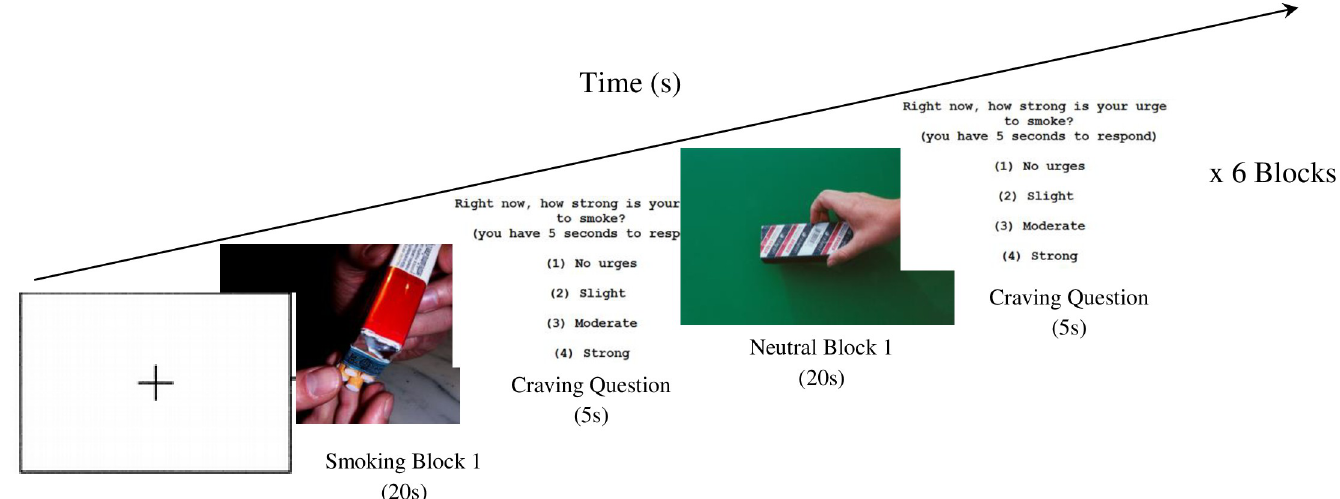
Fig 4. Design for smoking cue reactivity task paradigm (MRI task). During each MRI scan, participants will be presented images for approximately 7 minutes whilst being asked regarding their cigarette craving in between the blocks. The smoking block will consist of pictures related to smoking whilst the neutral block will have neutral images. Each block will last for 35 seconds for a total of 6 blocks. Blood oxygen level signal will be measured during this task. � Photos were taken from the Geneva Smoking Pictures (Khazaal et al. 2012).